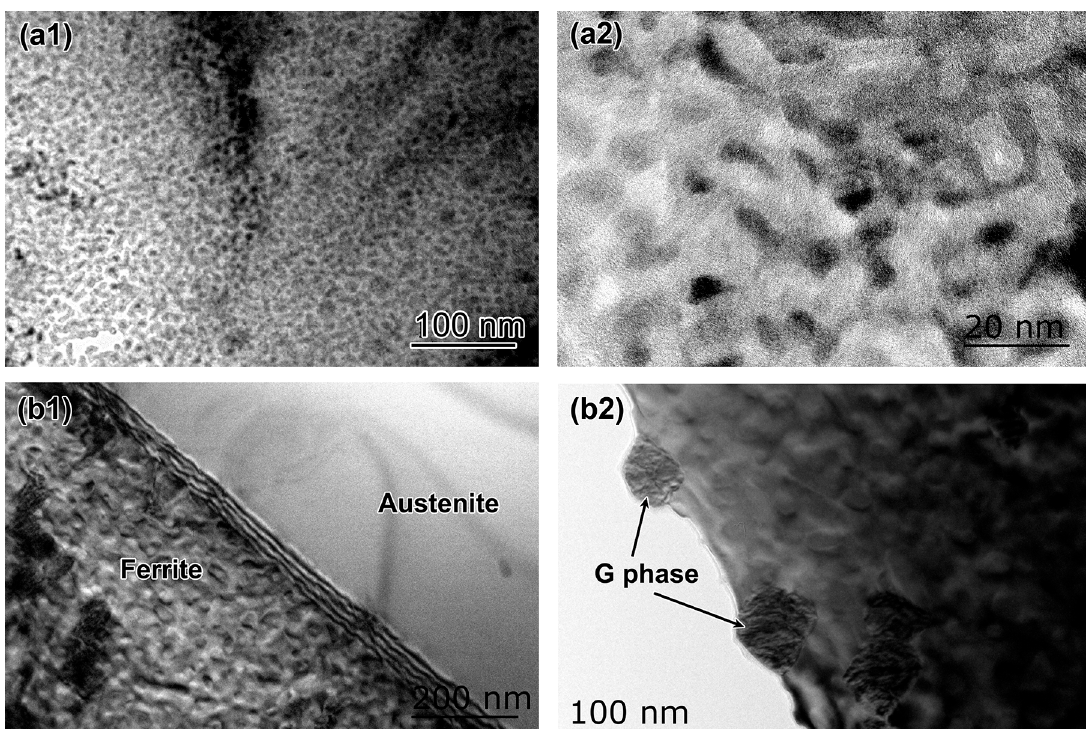
Figure 3. Bright-field TEM micrographs for Z3CN20.09M DSS specimens aged at different temperature (a) 450 ℃ and (b) 500